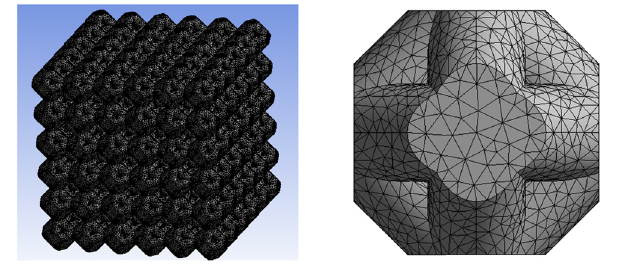
Figure 3: The grid division meshing map.